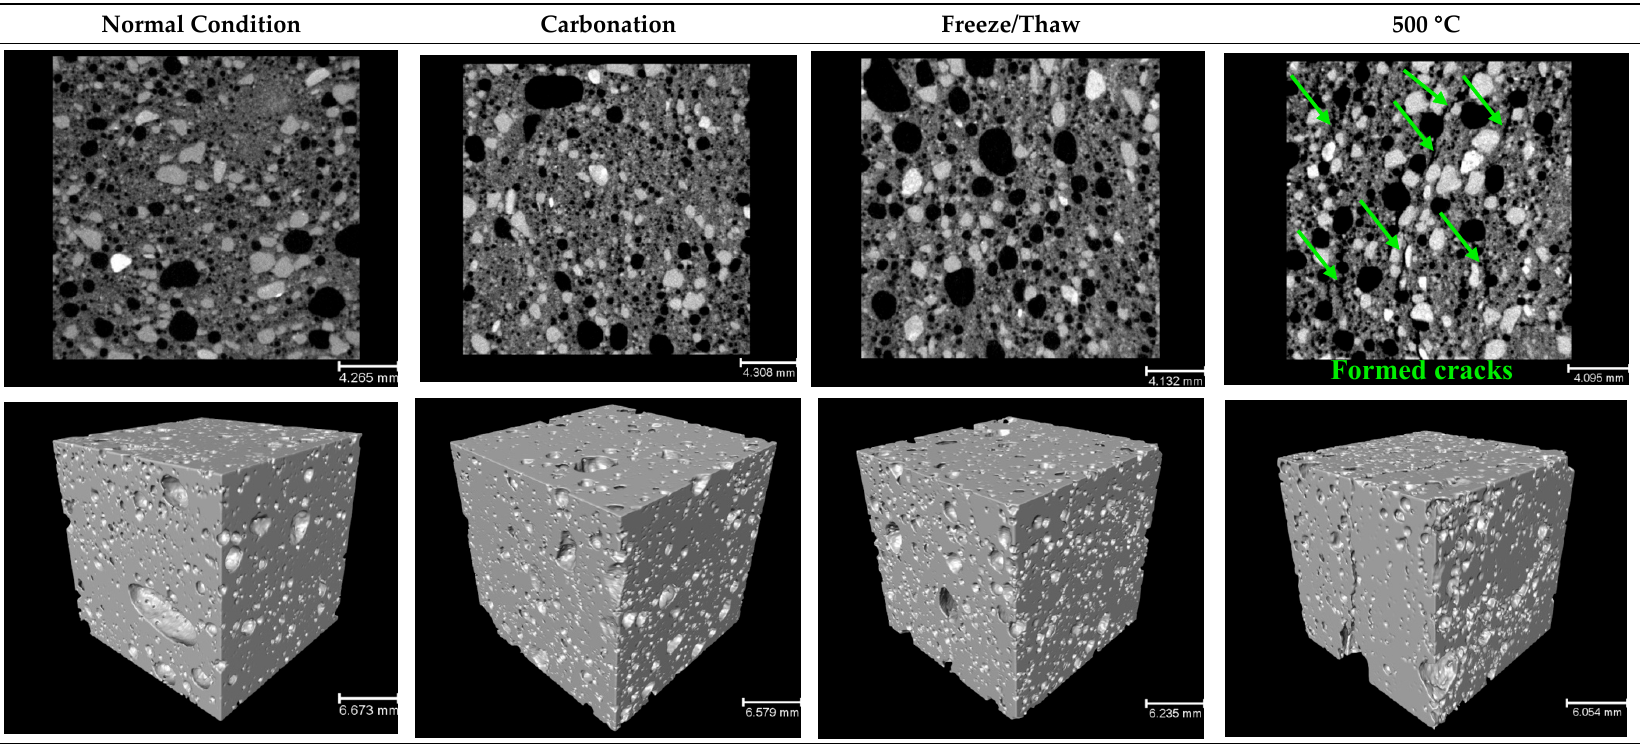
Figure 19. Representative 2D and 3D reconstructions of SW50/GW10-2% Fiber-30% Foam, showing the impact of different test conditions on the porous structure.